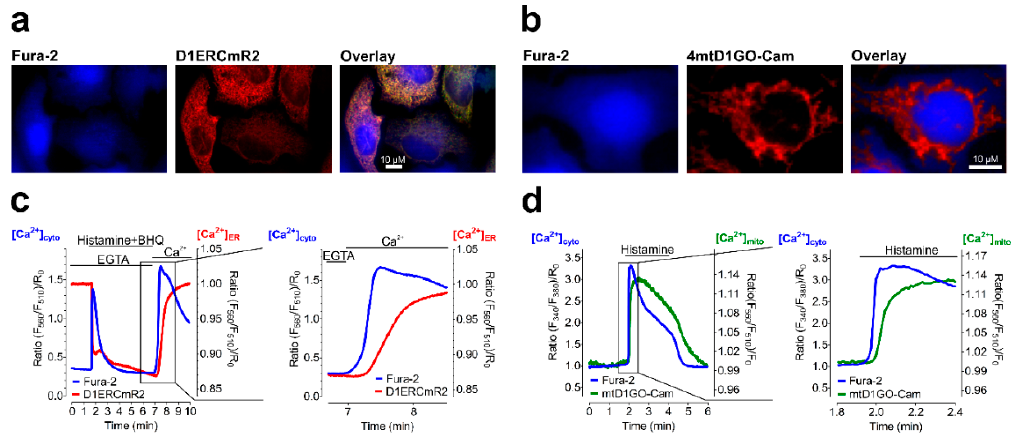
Figure 5. Correlation of subcellular Ca 2+ dynamics using genetically encoded probes and Fura-2. ( a ) Fluorescence wide-field microscopy images of HeLa cells loaded with Fura-2 (blue, left image) and expressing a FRET-based, red-shifted Ca 2+ sensitive probe targeted to the lumen of the ER (D1ERCmR2, red, middle image). Right image shows the overlay of both fluorescence images. Scale bar represents 10 µM. ( b ) Fluorescence wide-field microscopy images of a HeLa cell loaded with Fura-2 (blue, left image) and expressing a FRET-based, red-shifted Ca 2+ sensitive probe localizing in the mitochondrial matrix (4mtD1GO-Cam, red, middle image). Right image shows the overlay of both fluorescence images. Scale bar represents 10 µM. ( c ) Representative single cell response of a HeLa cell expressing D1ERCmR2 (red curve, both panels), additionally loaded with Fura-2 (blue curve, both panels) upon cell stimulation with Histamine and BHQ, in the absence (EGTA) or presence of Ca 2+ as indicated in the panels. Right panel shows a zoom as indicated in the left panel, demonstrating the correlation of Ca 2+ in the cytosol and endoplasmic reticulum. ( d ) Representative single cell response of a HeLa cell expressing mtD1GO-Cam (green curve, both panels), additionally loaded with Fura-2 (blue curve, both panels) upon cell stimulation with Histamine as indicated in the panels. Right panel shows a zoom as indicated in the left panel, demonstrating the correlation of Ca 2 + in the cytosol and the mitochondrial